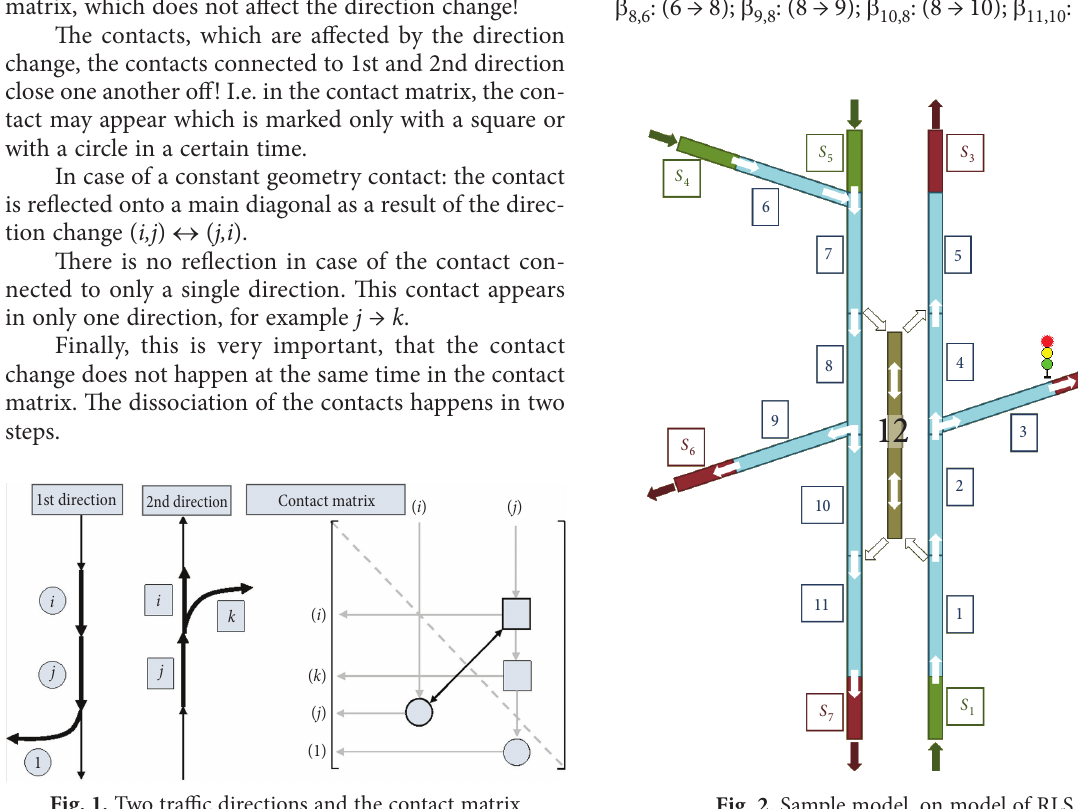
Fig. 1. Two traffic directions and the contact matrix Fig. 2. Sample model, on model of